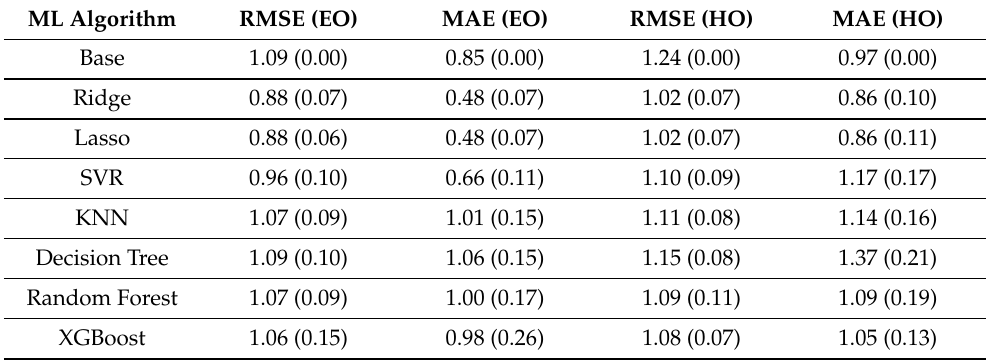
Figure 7. The different number of clusters using silhouette method over eudaimonic and hedonic variables. ( a ): number of clusters = 2 and ( b ): number of clusters = 3. Parameter n_clusters determines the number of clusters. The average value of the Silhouette coefficients is shown with a red dashed line. Table 4. EHO prediction results (regression problem) using U-F features. Nested cross-validation with 10 outer and five inner splits. EO (Eudaimonic orientation) and HO (Hedonic orientation). Numbers are the mean value of 10 outer splits. Numbers in parenthesis indicate the standard deviation